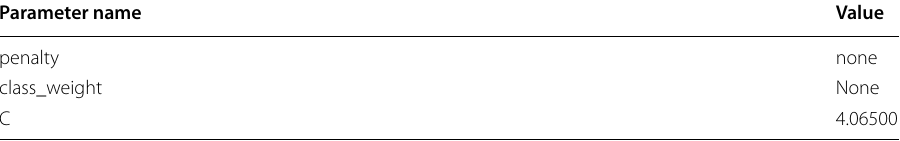
Table 97 Modes of LR tuned hyperparameter values for experiments with the keylogging dataset